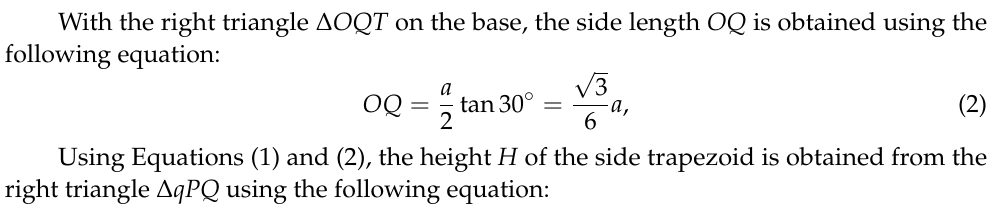
Figure 7. Diagram of the shape parameters of the flat part with truss core unfolded.